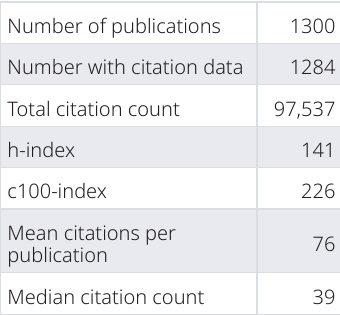
Table 4. Study level citation statistics from Scopus as of 15/1/2021. The values are taken from the metrics web page generated by the pipeline. A screenshot of this page is available in the output data (see data